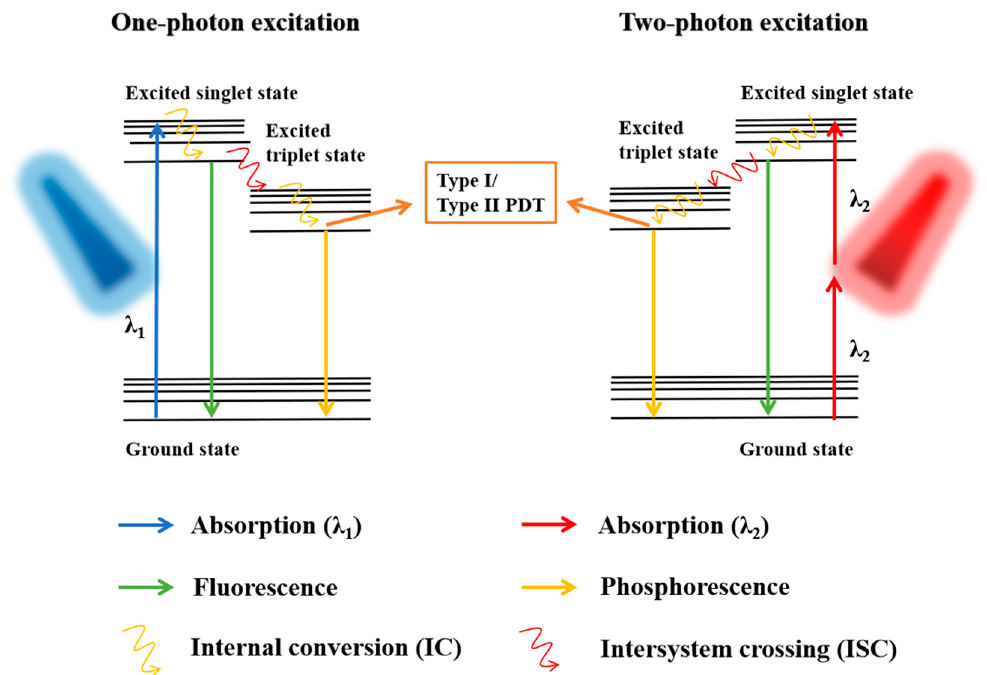
Figure 3. Photosensitizer activation through one-photon excitation and two-photon excitation (TPE). The TPE requires two photons of approximately half the energy compared to the energy needed in one-photon excitation.